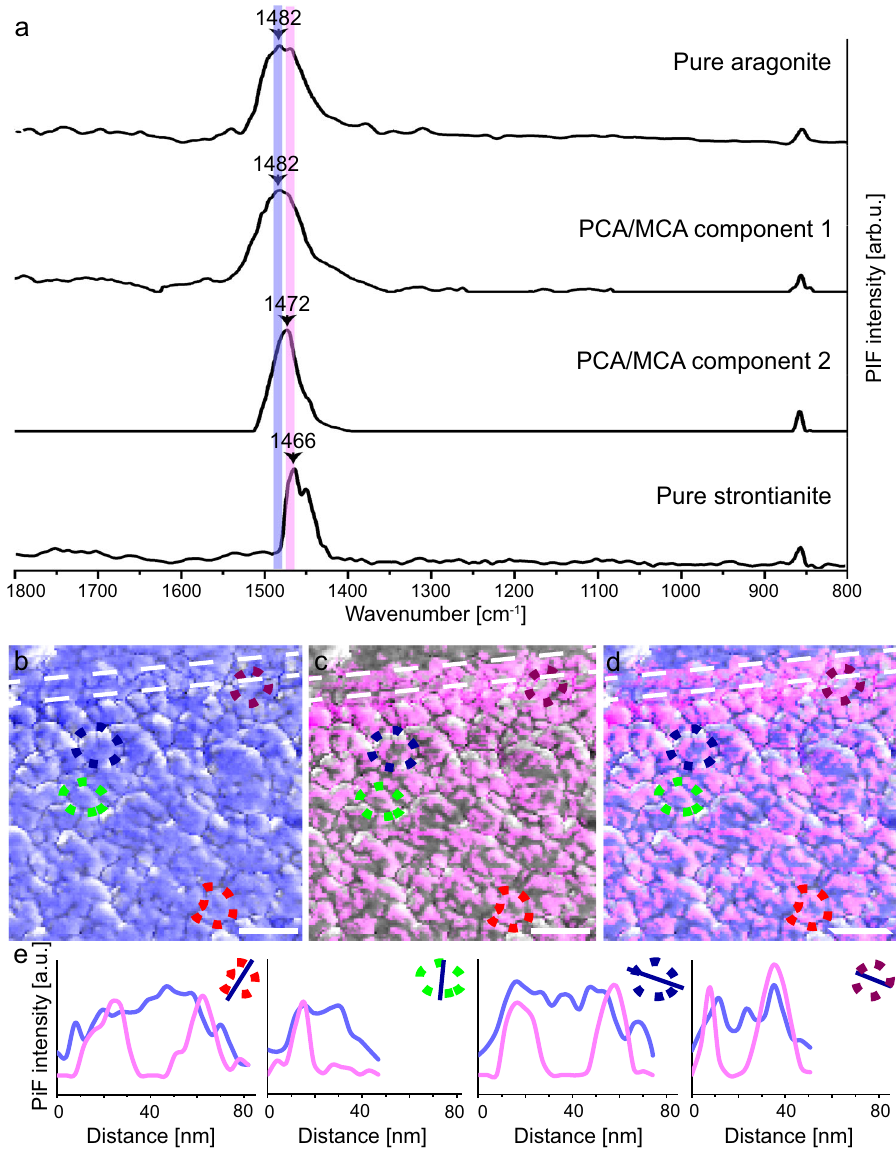
Fig. 6 | Principal component analysis and multivariate curve resolution (PCA/ MCR) applied to Sr-labelled nacre. PCA/MCR was used to deconvolve the indi- vidualspectraunderpinningtheHyPIRmapshowninFig.5. a Twopurecomponent spectra were de fi ned and corresponding maps showing the regions where these purespectraaremostprevalentwereextracted.ThePCA/MCRcomponentspectra showtheirmaximumintensitiesatdifferentwavenumbers,namelyat1482cm − 1 and at 1472cm − 1 that correspond to aragonite and Sr-rich aragonite, respectively. The components are presented together with PiFM spot measurements of geological aragonite and synthetic strontianite reference materials for comparison (see method for details). The peak at 1472cm − 1 , de fi ned as component 2, has an inter- mediate position between the main bands of aragonite and strontianite that sug- gestthiscomponentconsistsofastrontianiteandaragonitemechanicalmixtureor crystallisation pathway of nacre and represent phase separations combined with stabilisation of ACC by trace metal ions and/or organic molecules expelled upon crystallisation of aragonite 48 . Similarly, we interpret the Sr heterogeneity observed here as a result of phase transformation of ACC con fi ned within nanogranules that are caused by the phase separation and the exclusion of excess Sr upon crystal- lisation of aragonite.